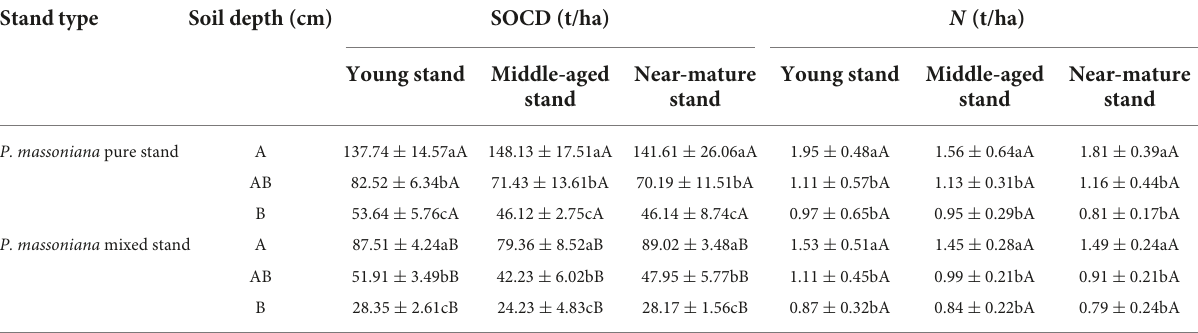
TABLE 3 Analysis results of soil carbon and N of different age groups and different depths in pure and mixed stands of P. massoniana . Stand type Soil depth (cm) SOCD (t/ha) N (t/ha) Young stand Young stand